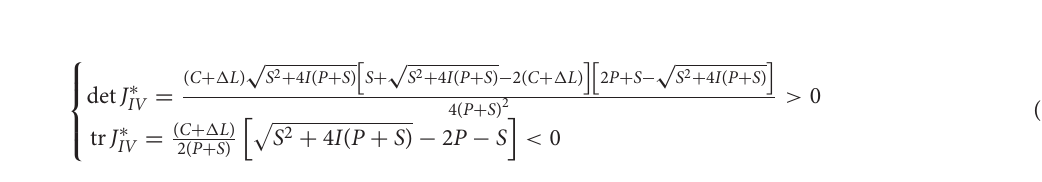
FIGURE 4 | Evolutionary stability of dynamic mechanisms ( S 3, P 9, I 3, C 1, 1 L = = = = =